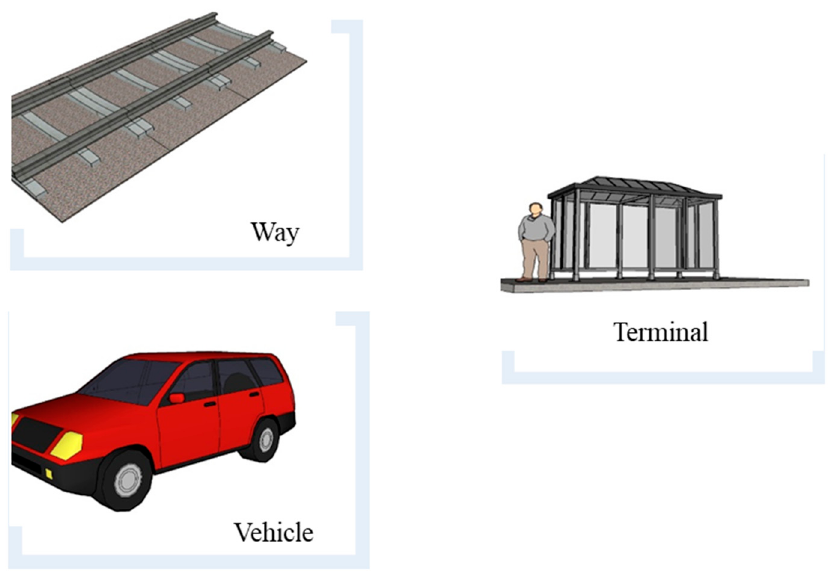
Figure 1. Sub-division of the transportation systems.